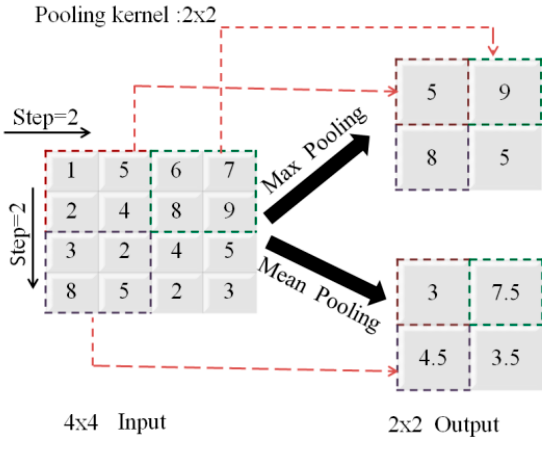
Figure 6. Convolution operation.